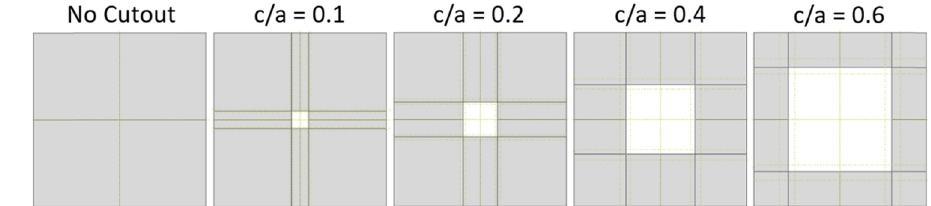
Figure 6: Panels with and without central cutout.